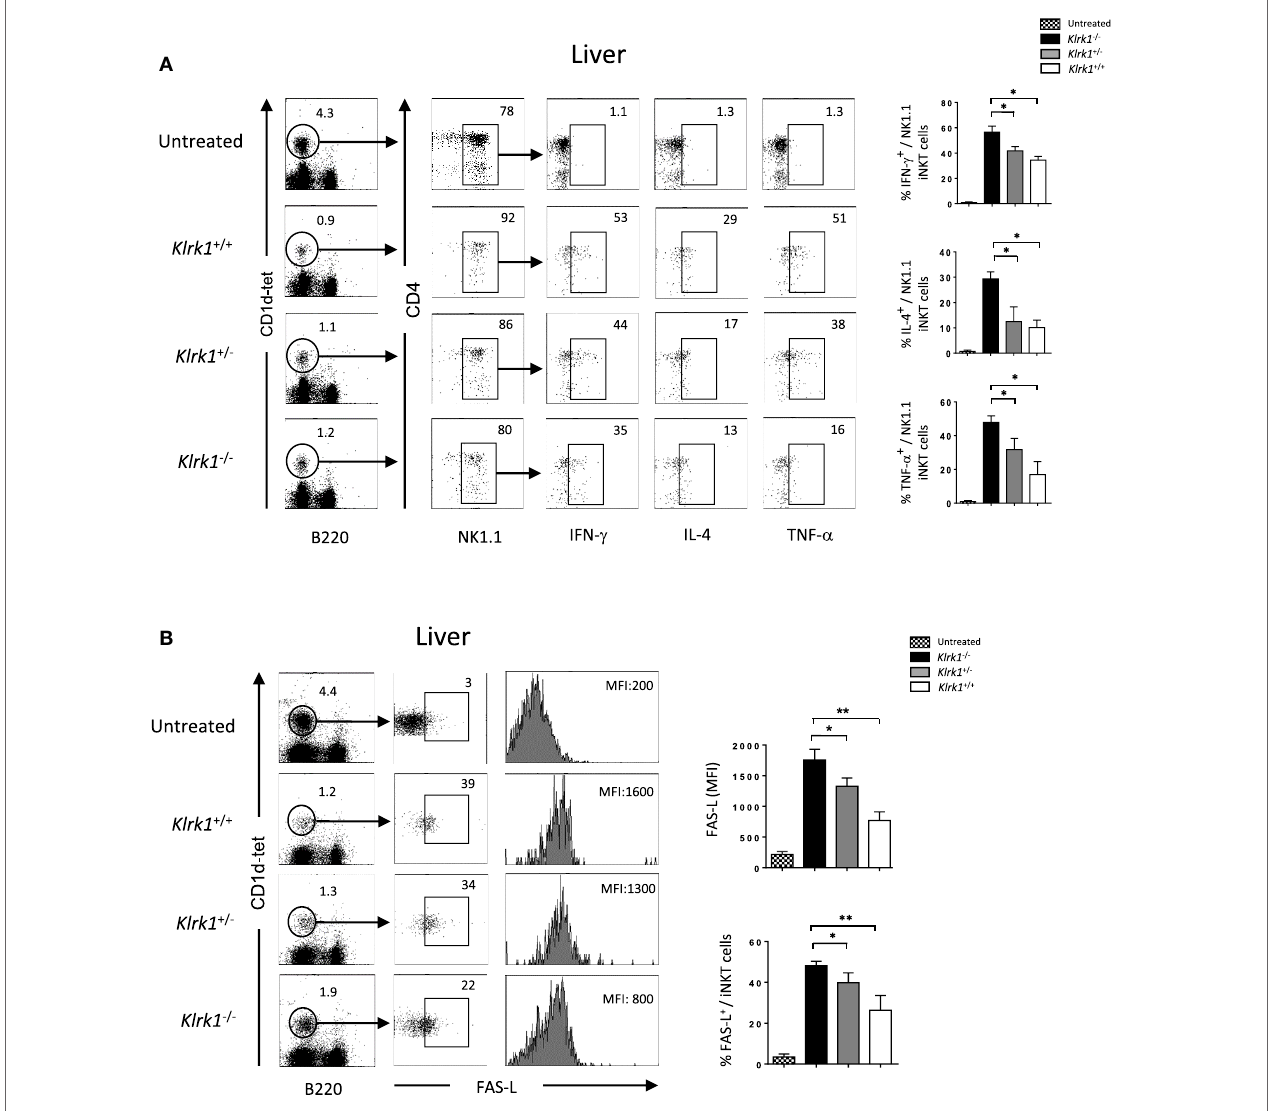
FigUre 5 | Reduction of cytokine production and FAS-L expression by liver invariant natural killer T cell (iNKT) cells in the absence of NK group 2 member D upon concanavalin A (Con A) administration, Representative intracellular staining of interferon (IFN)- γ , interleukin (IL)-4, and TNF- α production (a) , or FAS-L expression (B) by liver NK1.1 + iNKT after 2 h of i.v. administration of Con A (15 mg/kg). iNKT cells are defined as tet + B220 − . The frequencies of positive cells and mean florescence intensity (MFI) of FAS-L are shown in the histograms. Results are from three experiments where three mice of each genotype were used per experiment and presented as mean ± SD. Numbers represent percentages. Significance is represented by an asterisk and was evaluated with non-parametric Mann–Whitney U